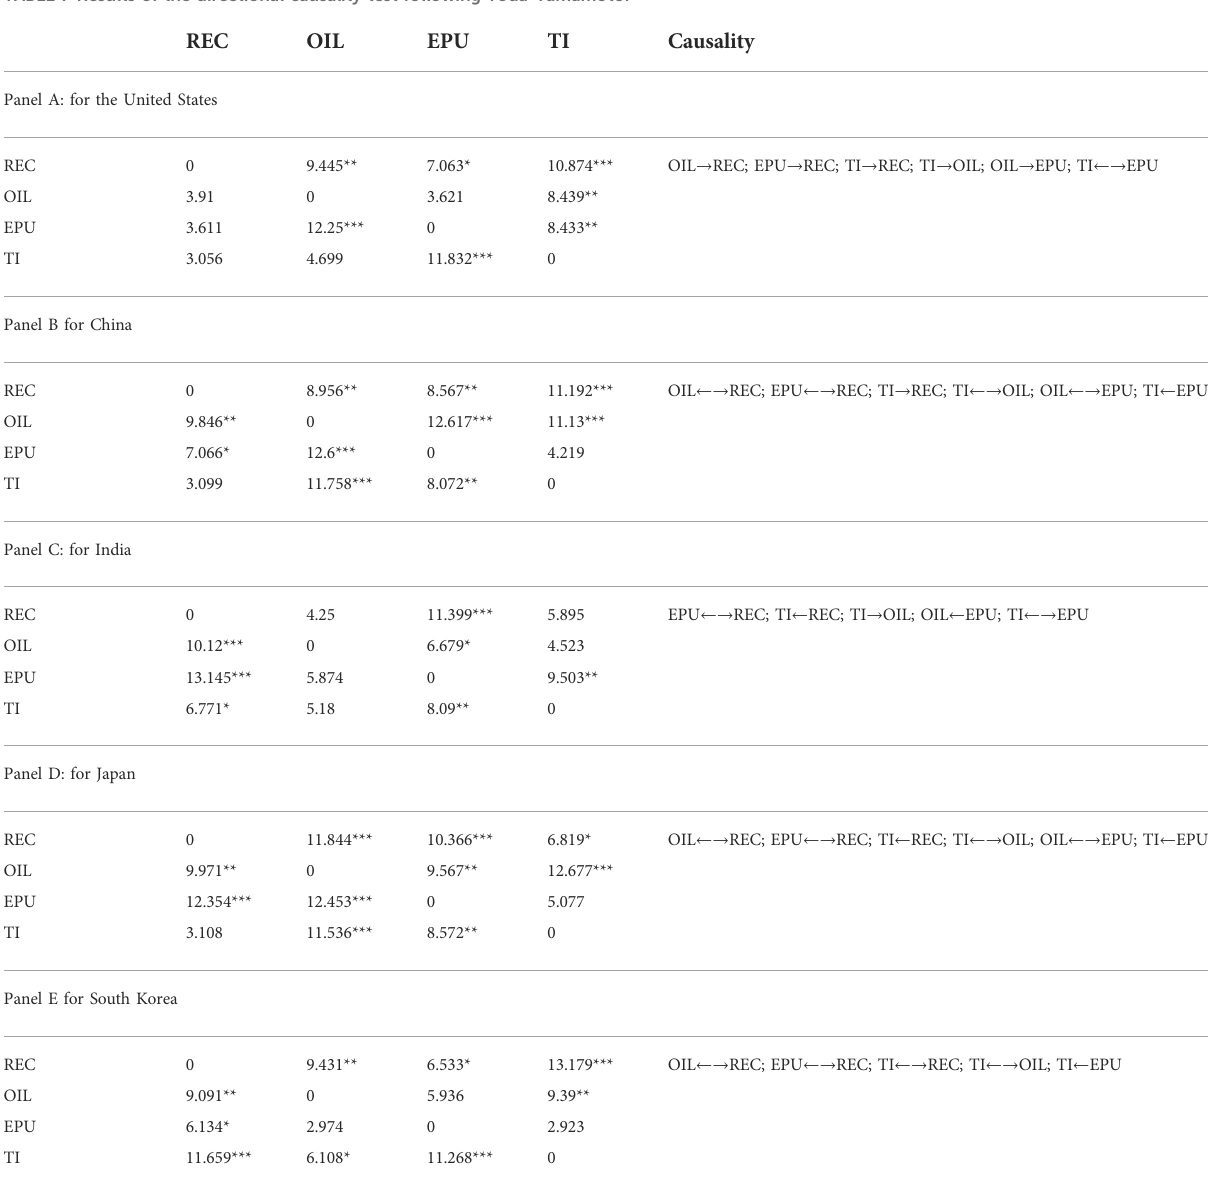
TABLE 7 Results of the directional causality test following